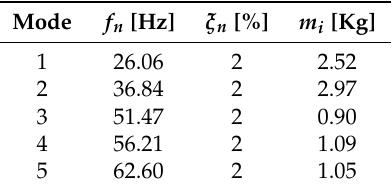
Table 2. Eigenfrequencies, damping ratios and modal masses of the five-DOF system.